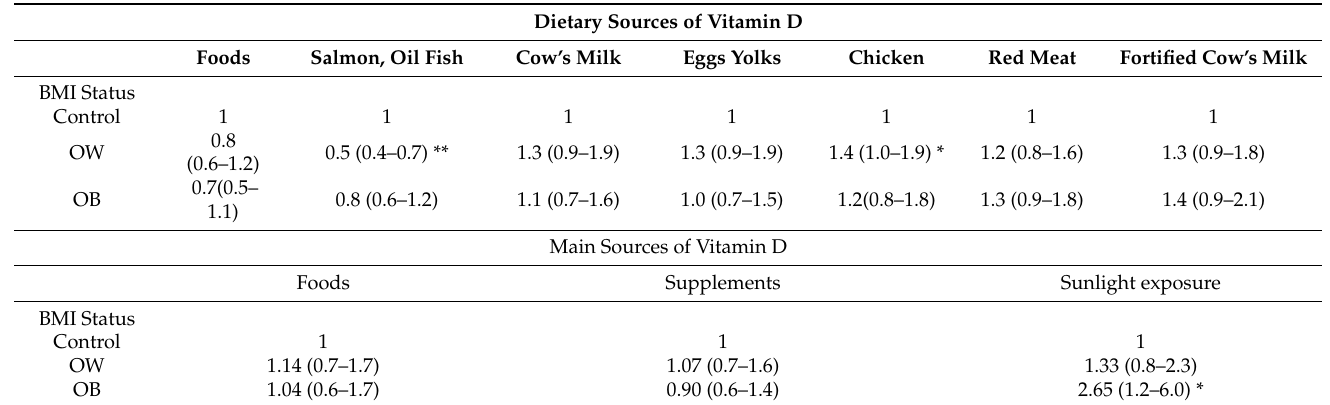
Table 3. Knowledge of VD sources as predictors of BMI status. Dietary Sources of Vitamin